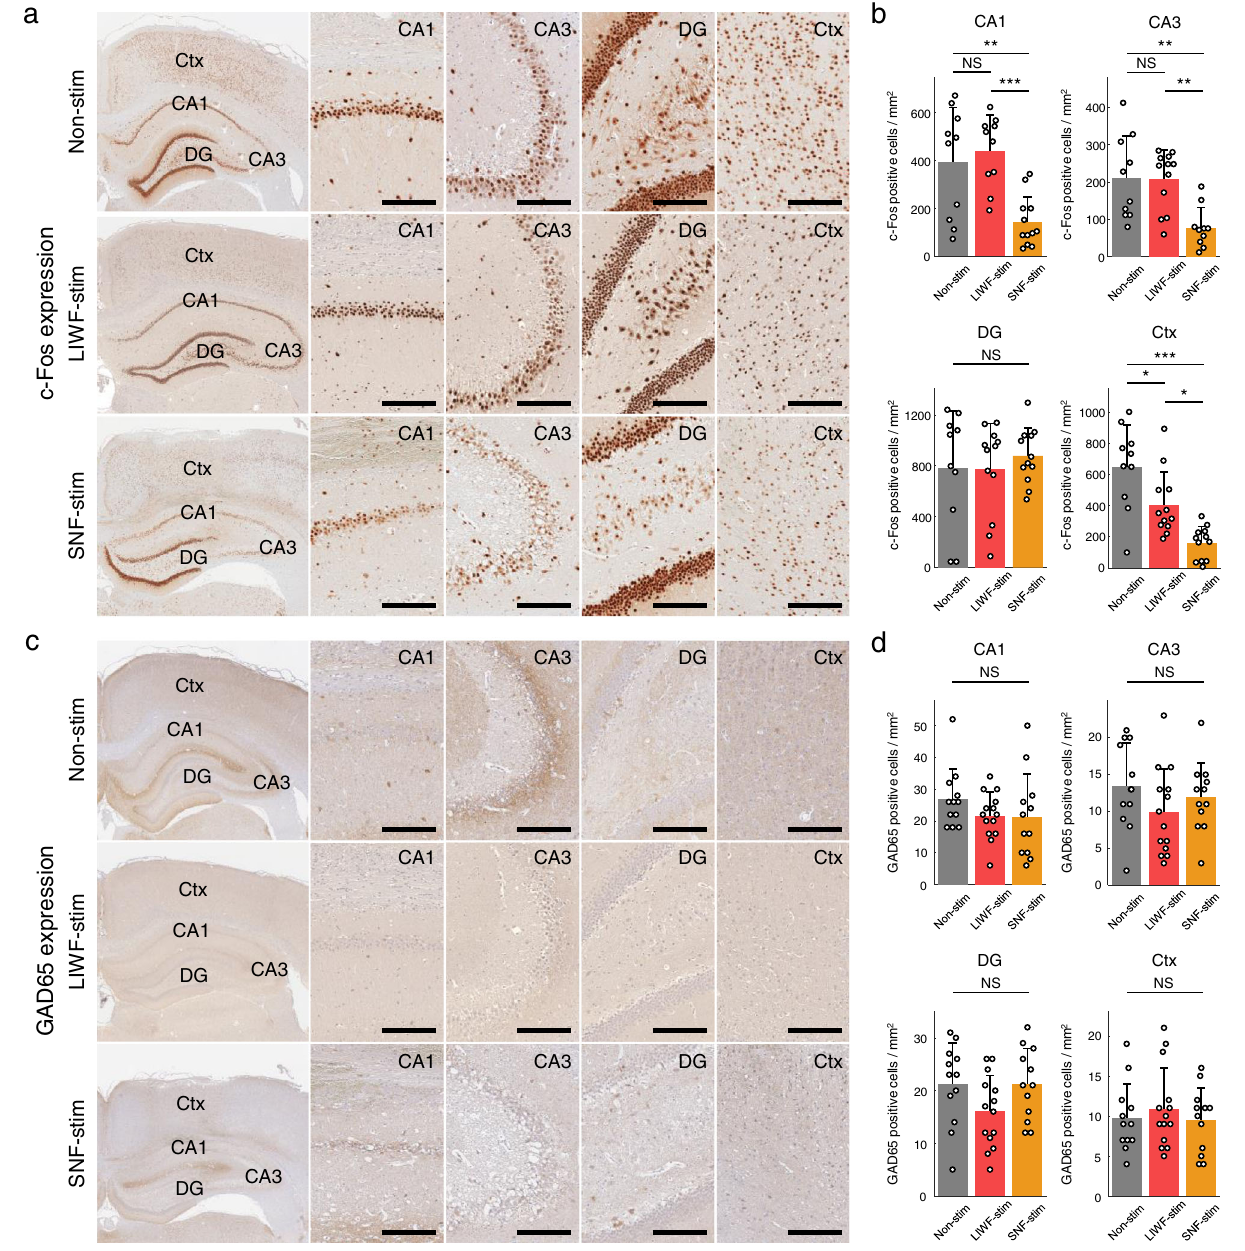
Fig. 6 | Analysis of the therapeutic effects of SNF stimulation in biological levels. a – d Comparisons of c-Fos ( a , b ) and GAD65 ( c , d ) labeling in the hippo- campus andcortexwithnon-stimulation, LIWF stimulation, and SNF stimulation in an acute SE model. a , c Representative brain sections of the KA-induced acute seizure model labeled with c-Fos and GAD65 ( n =6 rats per group). Magni fi ed images show gene expression in detail in the speci fi c regions including the CA1, CA3,DG,andcortex,respectively. b Quanti fi cationofc-Fospositivecellsintheunit area after non-stimulation, LIWF stimulation, and SNF stimulation treatment ( P =<0.001, 0.0014, 0.32 and < 0.001 for CA1, CA3, DG, and cortex each,